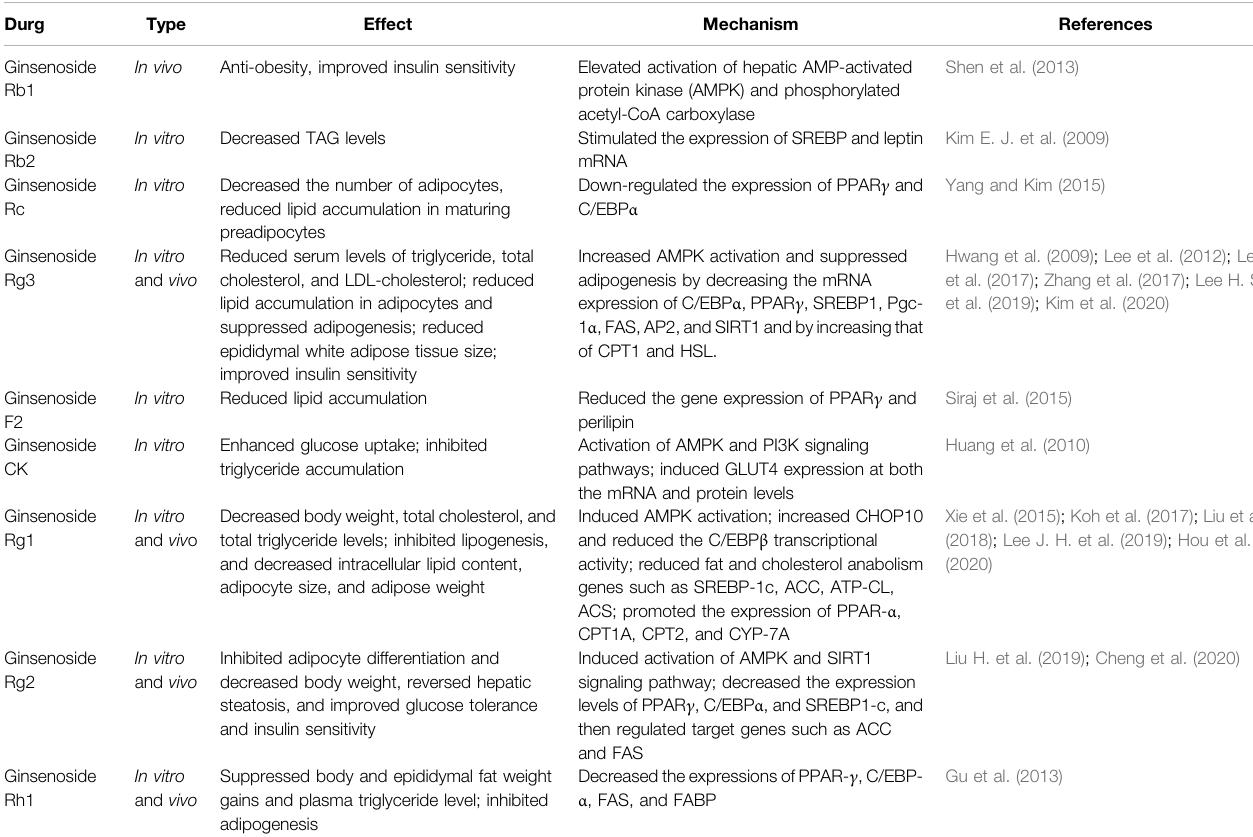
TABLE 1 | Effect of notoginsenosides on